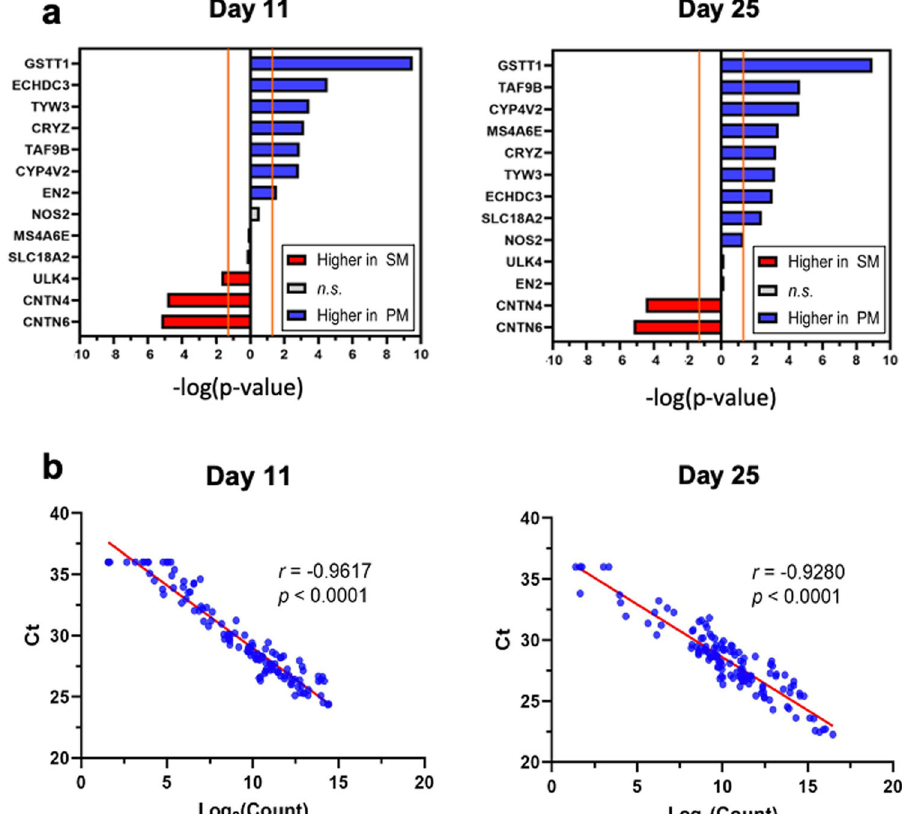
Fig. 5 RT-qPCR validation of RNA-seq fi ndings. a 13 of the genes identi fi ed as differentially expressed in SM and PM by RNA-seq on day 11 and day 25 of differentiation were validated by RT-qPCR. The statistical signi fi cance (-log p values) of the differential expression between PM and SM cultures evaluated are graphed. Grey-colored bars lying within the range of non-signi fi cant differences as delineated by two orange lines were not signi fi cantly differently expressed in PM and SM cultures as assessed by Rt-qPCR ( p > 0.05). b Correlation analysis of the expression levels of all genes analyzed by RT-qPCR and RNA-seq including the dopamine-lineage markers (Fig. 1c) across all four SM and PM hiPSC lines are graphed for day 11 and day 25 (Log 2 (Count) versus Ct; Pearson correlation analysis, two-tailed p -value). RNA-seq counts were multiplied by a factor of 100 to accommodate logarithmic scaling on the x-axis of the graphs ( c (Fig. 7c, d). The biosynthesis of aromatic amino acids (phenyla- lanine, tyrosine and tryptophan) was identi fi ed as the most signi fi cantly different pathways by RPLC pos/ HILIC pos, but did